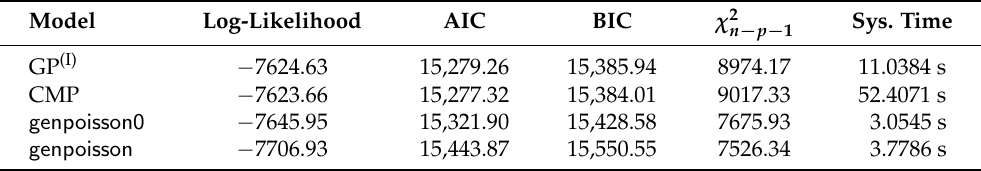
Table 11. Comparisons of goodness-of-fit among the GP (I) regression model, CMP regression model, log-lambda based GP regression model with constraint λ (cid:62) 0 and the log-lambda based GP regression model without constraint on λ